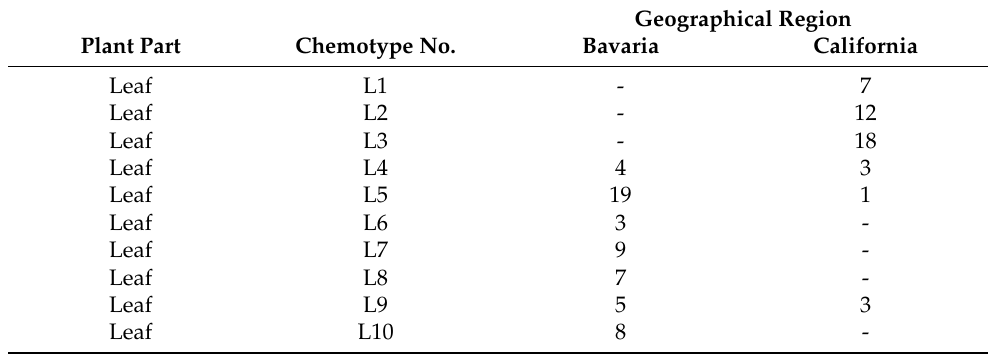
Table 2. Occurrence of plant-part specific chemotypes (for chemical composition see Figure 1) in Erodium cicutarium plants. The number of plants, which were found to belong to the different leaf, blossom and fruit chemotypes are listed for the two geographic regions of plant origin: Bavaria (native range) and California (invasive range). Total n = 99 plants (55 from Bavaria and 44 from California). Geographical Region Plant Part Chemotype